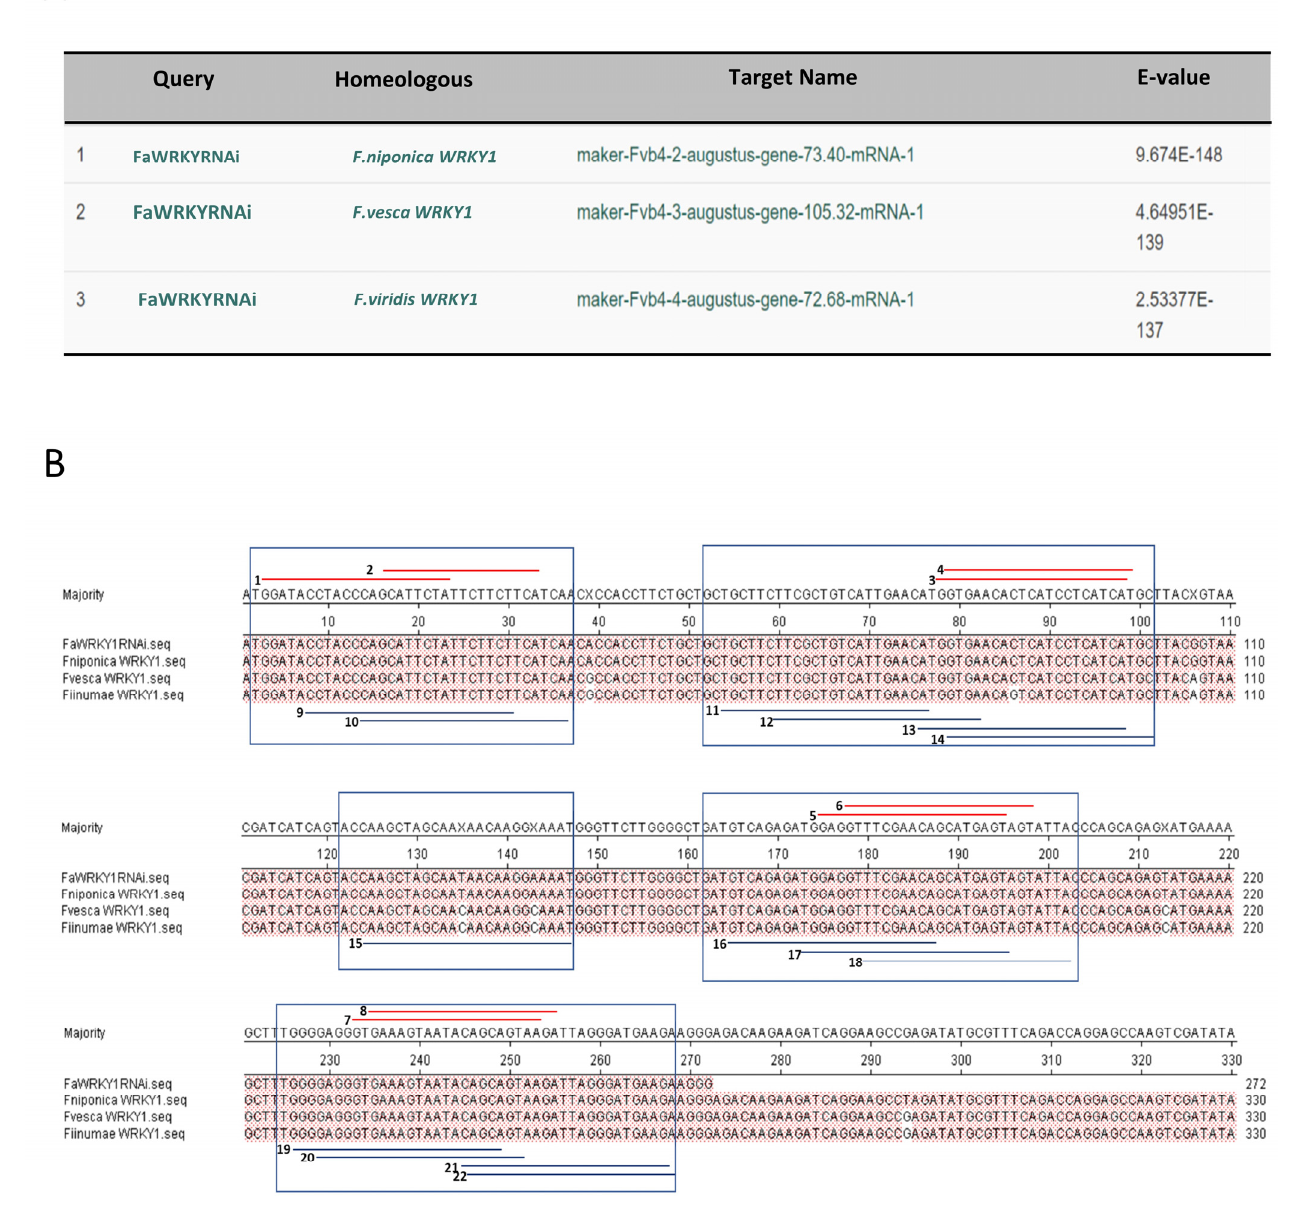
Figure 2. The FaWRKY1 DNA fragment selected for dsRNAi silencing (FaWRKYRNAi). ( A ) BLAST of the 272 bp DNA fragment of FaWRKY1 against Fragaria × ananassa Camarosa Genome v1.0.a1 Transcripts database, adjusting the setting for the search to E-value 0.001 and Match/Mismatch Scores 1/ − 2. ( B ) Partial local alignment of the sequence, corresponding to three homeologs of FaWRKY1 and the selected FaWRKY1 DNA fragment. FaWRKY1RNAi corresponds to the 272 bp DNA fragment used in the intragenic dsRNAi-inducing unit; F. niponica WRKY1, maker-Fvb4-2-augustus-gene-73.40-mRNA-1; F. vesca WRKY1 , maker-Fvb4-3-augustus-gene-105.32-mRNA-1; and F. viridis WRKY1, maker-Fvb4-4-augustus-gene-72.68-mRNA-1. Red and purple lines indicate the position of each predicted siRNA obtained by invivoGen software and Whitehead, respectively. Predicted siRNA are mostly grouped into “hot spot” RNAi candidate regions